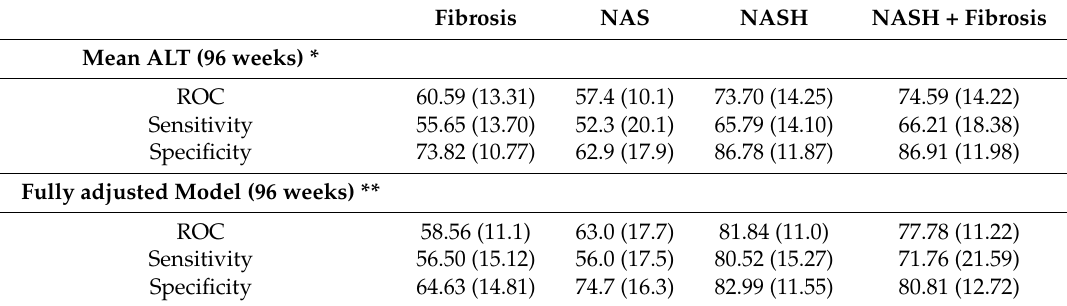
Table 4. Classification and Regression Trees (CART), Model Performance with 5-fold cross validation across 20 replications—average (standard